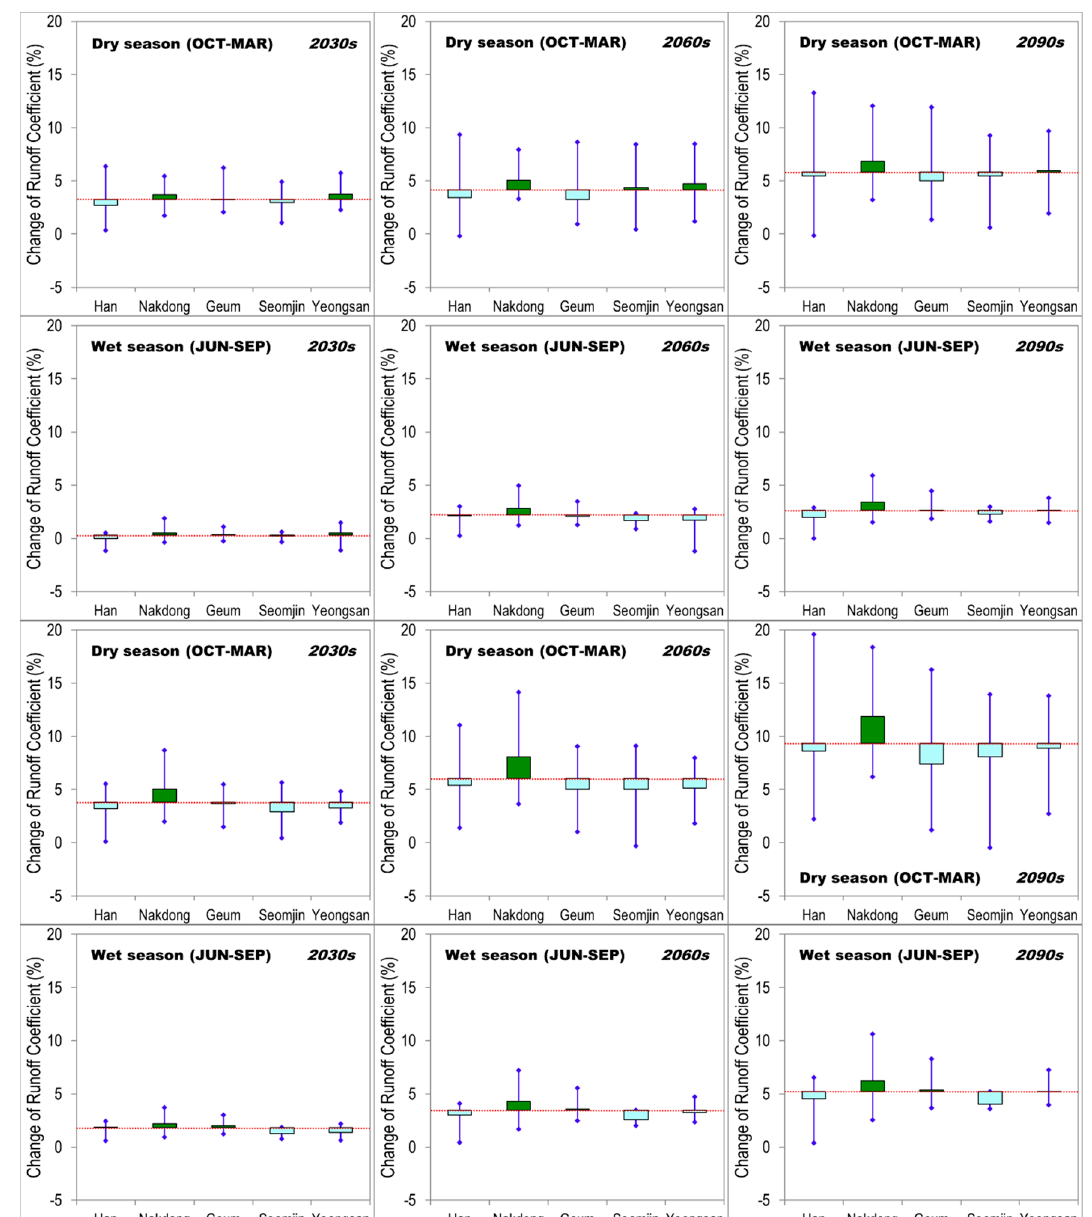
Figure 8. Runo ff coe ffi cient variations in 5 major river basins (Han, Nakdong, Geum, Seomjin, and Yeongsan) referred to the baseline (1976–2005) during the dry and wet seasons in RCP 4.5 ( upper half ) and RCP 8.5 ( lower half ). The red dotted lines show the average value of change in the runo ff coe ffi cient of 109 subbasins. The light green boxes show the negative variations (lower than the average value), and the dark green boxes show the positive variations (higher than the average value). The blue whiskers show ranges of change rates of subbasins in each major